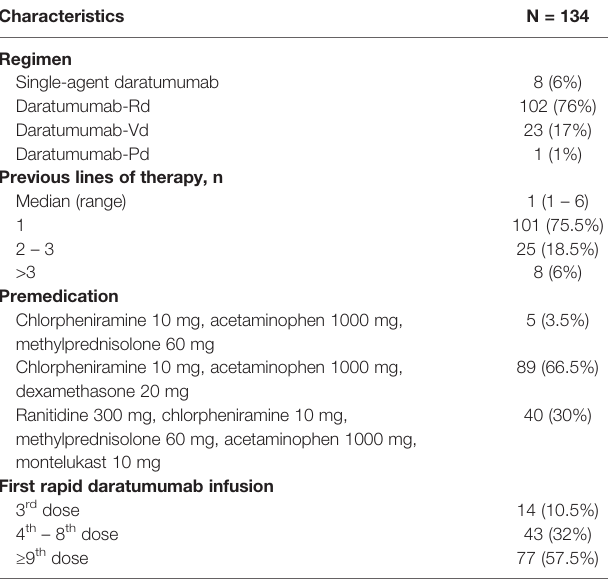
TABLE 1 | Daratumumab regimen.